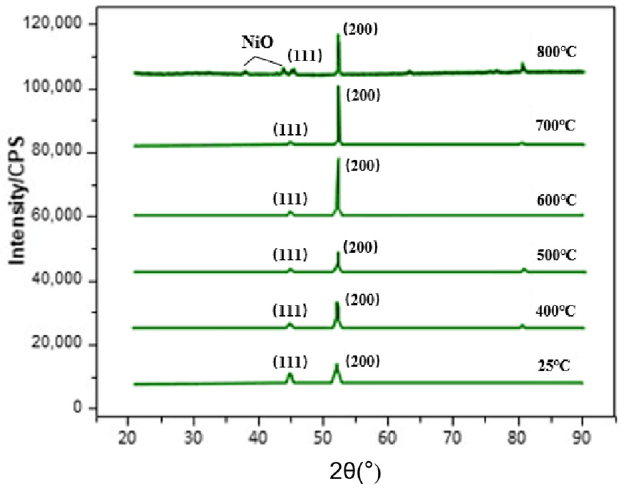
Figure 8. XRD pattern of Ni / ZrO 2 gradient coating after high temperature treatment.